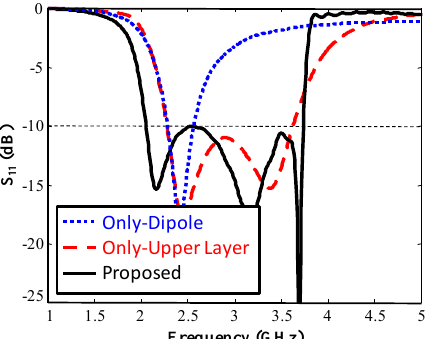
Figure 5: The computed radiation patterns of the antenna design at 2.2 GHz (left), 3.0 GHz (middle) and 3.6 GHz